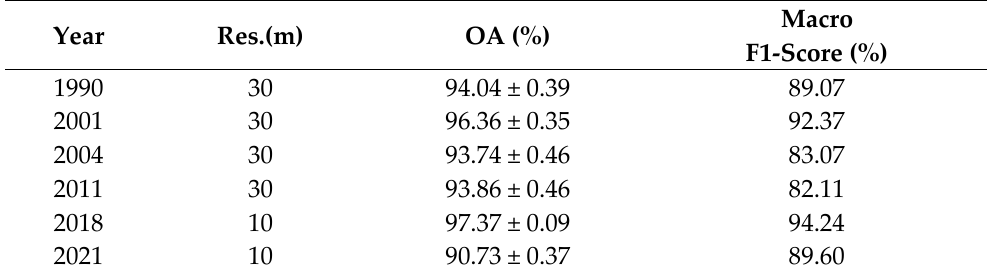
Table 3. List of OAs (%) and macro F1-score (%) for the classified multi-class time series of LC map- pings.